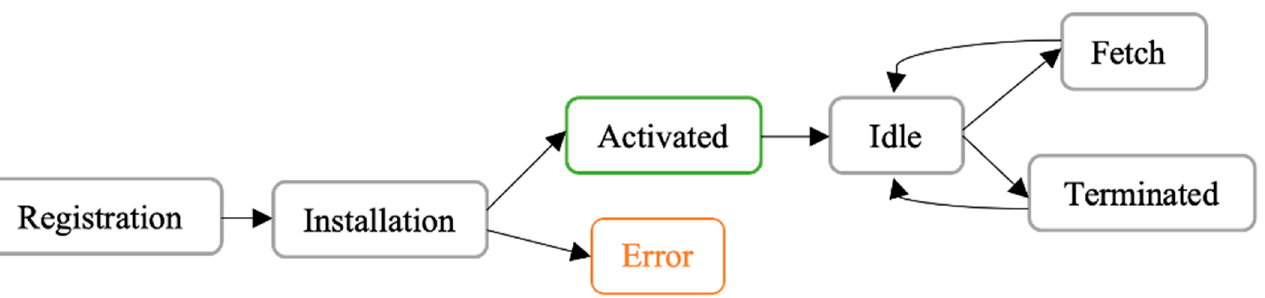
Figure 2. Service worker’s lifecycle .